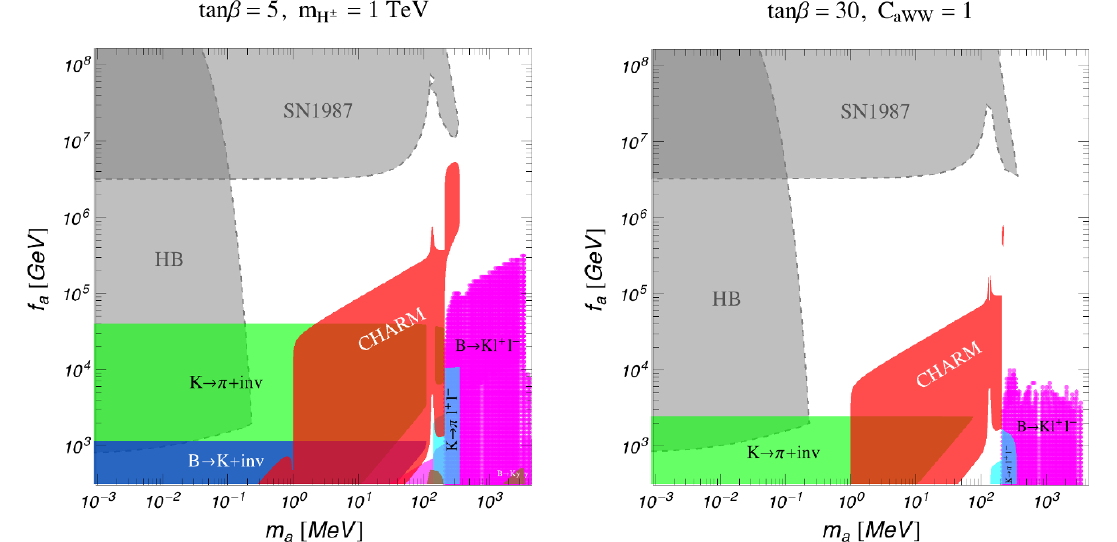
Figure 2 . Parameter region excluded by the FCNC constraints for (cid:12)eld theoretic ALP ( n u = 0 and (cid:3) a (cid:24) f a ). The left panel is for the case with a moderate tan (cid:12) = 5, in which the one-loop induced ALP couplings in (4.2) provide the dominant source of (cid:13)avor violation. The right panel is for the case with a larger tan (cid:12) = 30 satisfying (3.12), in which the e(cid:11)ective two-loop e(cid:11)ects associated with the ALP coupling (3.11) to the W -bosons, which was discussed in [18], provide the dominant constraints. Here we consider the type II 2HDM with m = 1 TeV as a benchmark model. The H (cid:6) results do not change much for other type of 2HDMs and SUSY models. Gray parts correspond to the parameter region excluded by the conventional astrophysical considerations (SN1987 + Red giant